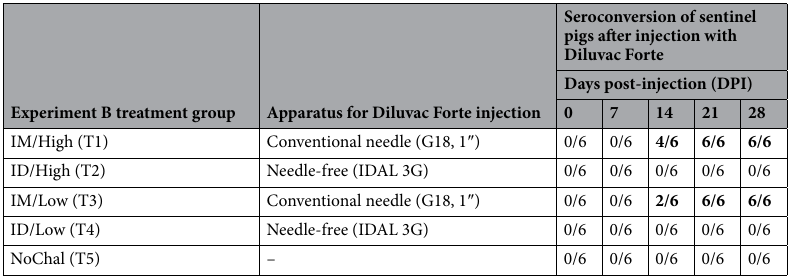
Table 4. Seroconversion of sentinel pigs in experiment B (Exp B) as measured by ELISA. Sera were considered positive for PRRSV antibodies if the S/P ratio was greater than 0.4 Values expressed as the number of positive sentinel pig(s)/total number of sentinel pigs (n = 6). Significant values are in